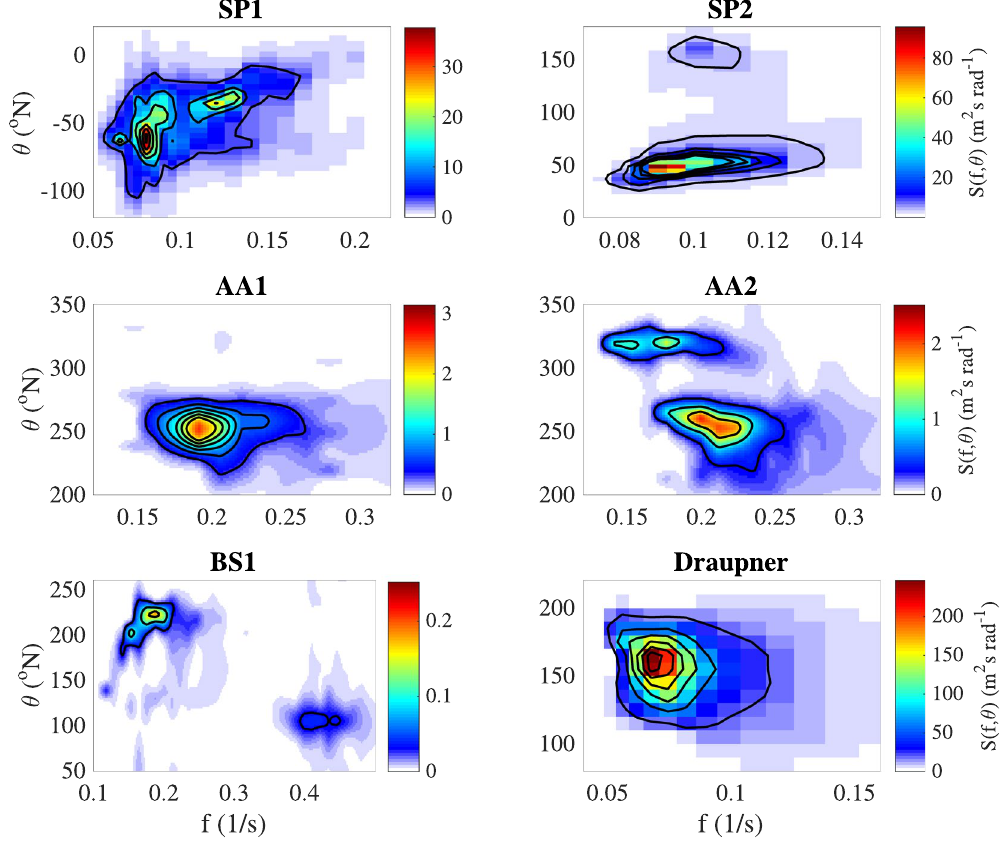
Figure 1. Frequency ( f ) - direction ( θ ) wave spectrum S during the stereo acquisitions, and for the Draupner case (throughout the paper we use flow direction of the wave energy). Station P spectra (SP1 and SP2) were derived from the directional WaveRider buoy parameters; Acqua Alta (AA1 and AA2) and Black Sea (BS1) spectra were derived from stereo data using the extended maximum entropy principle method. The Draupner spectrum was computed by the wave model ECWAM at 14-km resolution forced with ECMWF winds at 9-km resolution 22 . Given the wide range of energy levels, axis limits and color-scale change among